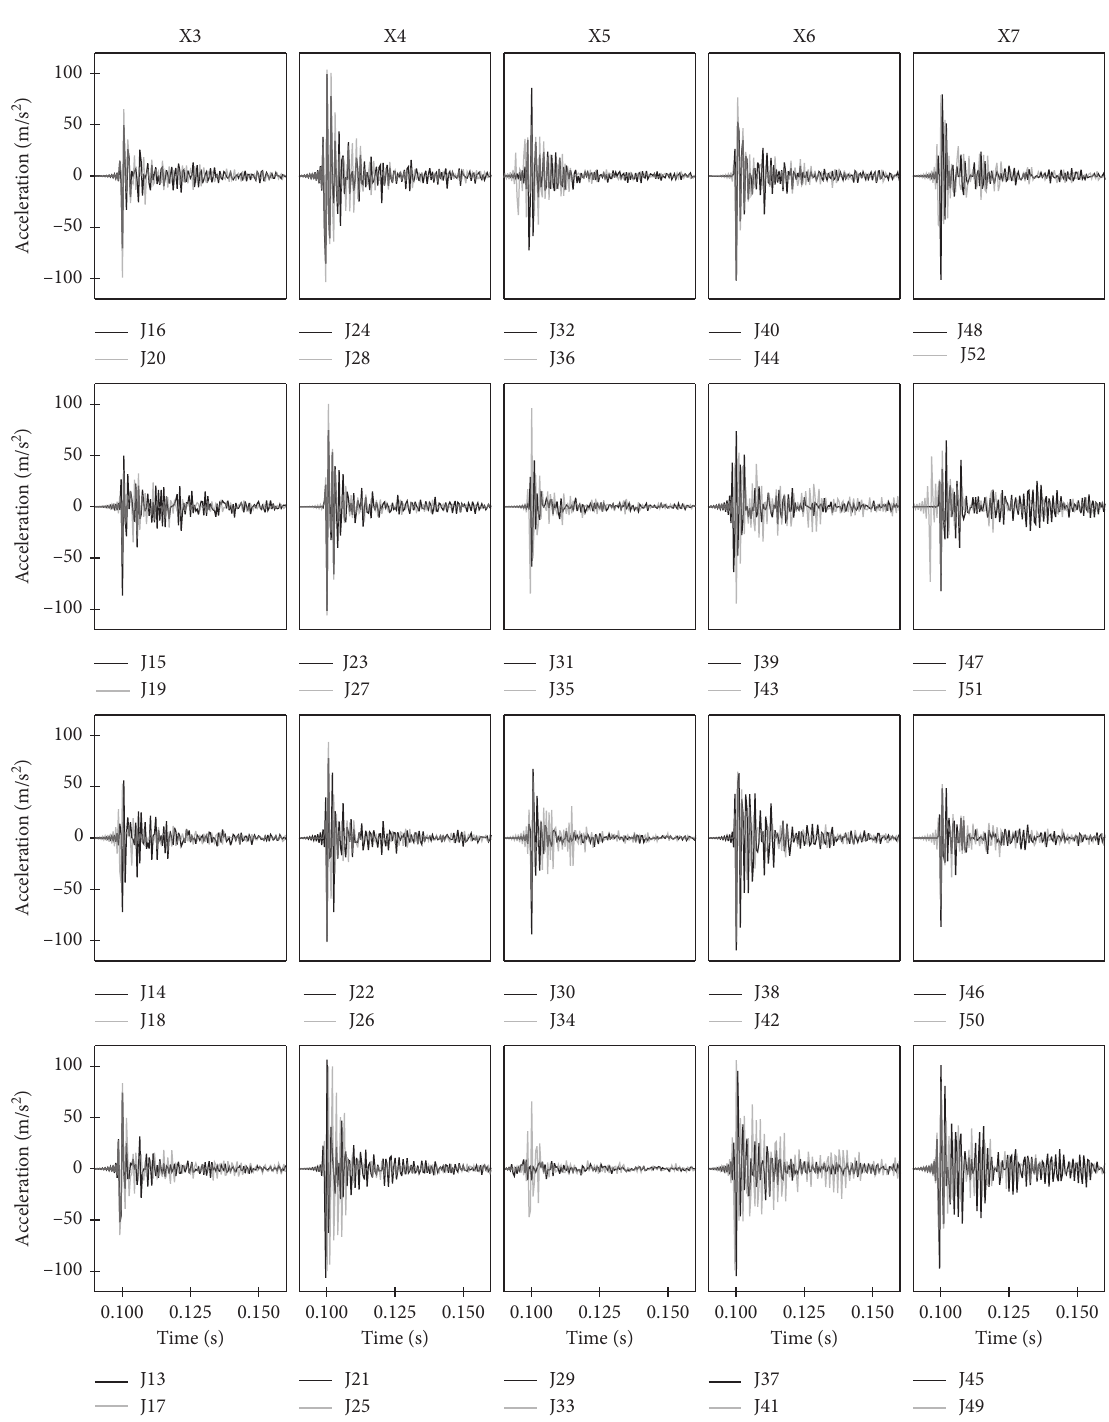
Figure 4: Comparison of the acceleration response measurements based on one impact for the joints in the middle part of the